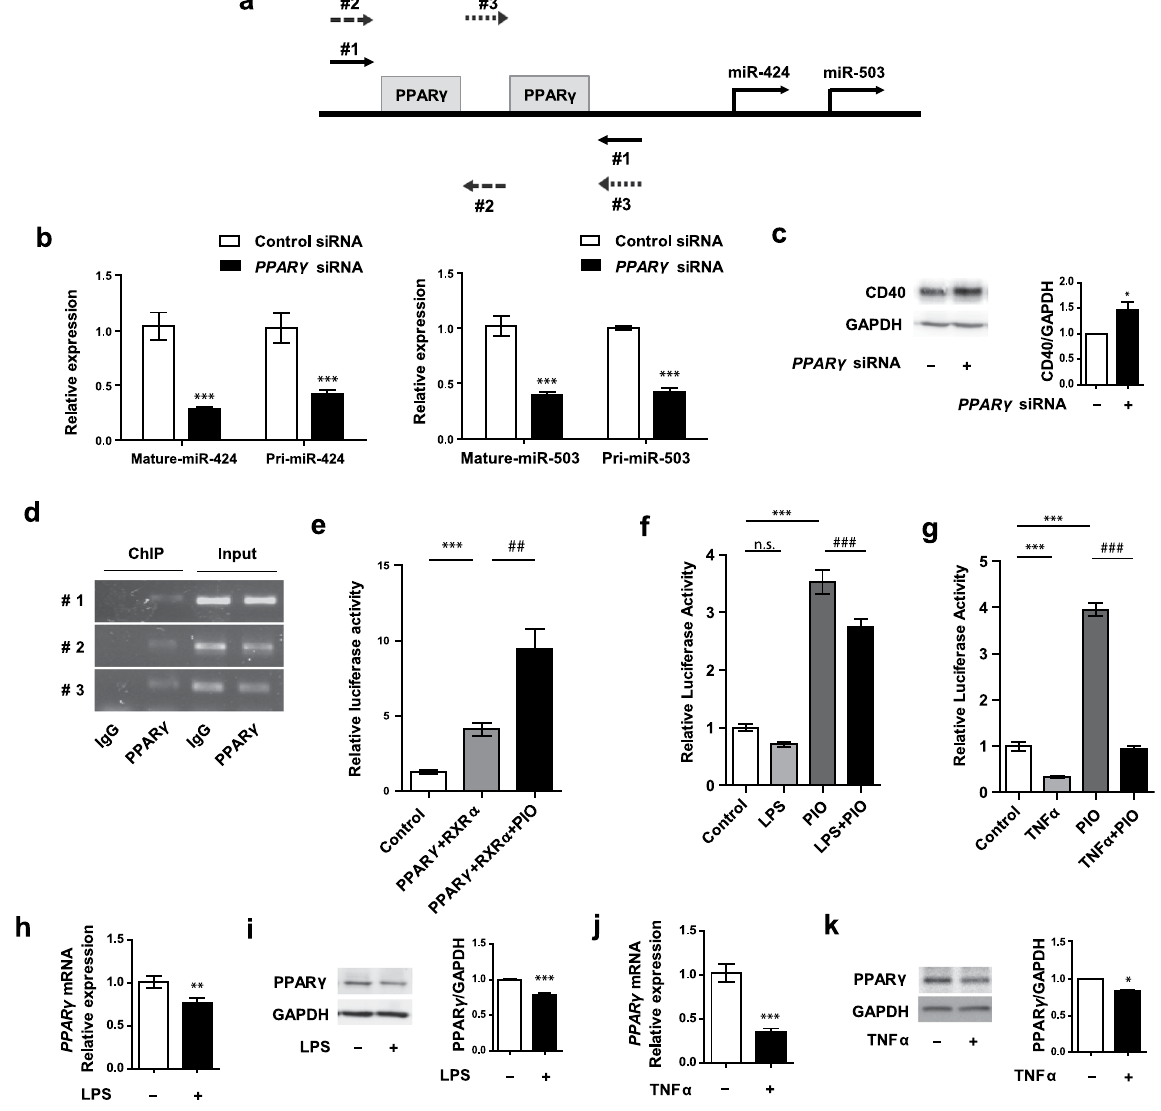
Figure 5. PPAR γ signaling regulates miR-424/503 expression. ( a ) Predicted PPAR γ binding sites on promoter region of miR-424 and miR-503 and the positions of PCR amplicons used in ChIP assays. ( b ) Mature and pri forms of miR-424 and miR-503 expression in response to PPAR γ knockdown. ( c ) CD40 protein expression in response to PPAR γ knockdown. ( d ) ChIP assay for investigating the binding sites of PPAR γ on miR-424/503 promoter region. The ChIP pull-down PCR products (left) and the inputs (right) are shown. ( e ) Relative luciferase activity of HUVECs co-transfected with miR-424/503 promoter luciferase construct and PPAR γ and RXR α with or without pioglitazone (10 μ M) stimulation for 24 h. ( f ) * P < 0.05, ** P < 0.01, *** P < 0.001 compared to controls. ## P < 0.01, ### P < 0.001 compared to PPAR γ + RXR α or PIO. n.s.: not significant. Error bars, s.e.m. Cropped gel images are shown; uncut gels are included in the Supplementary